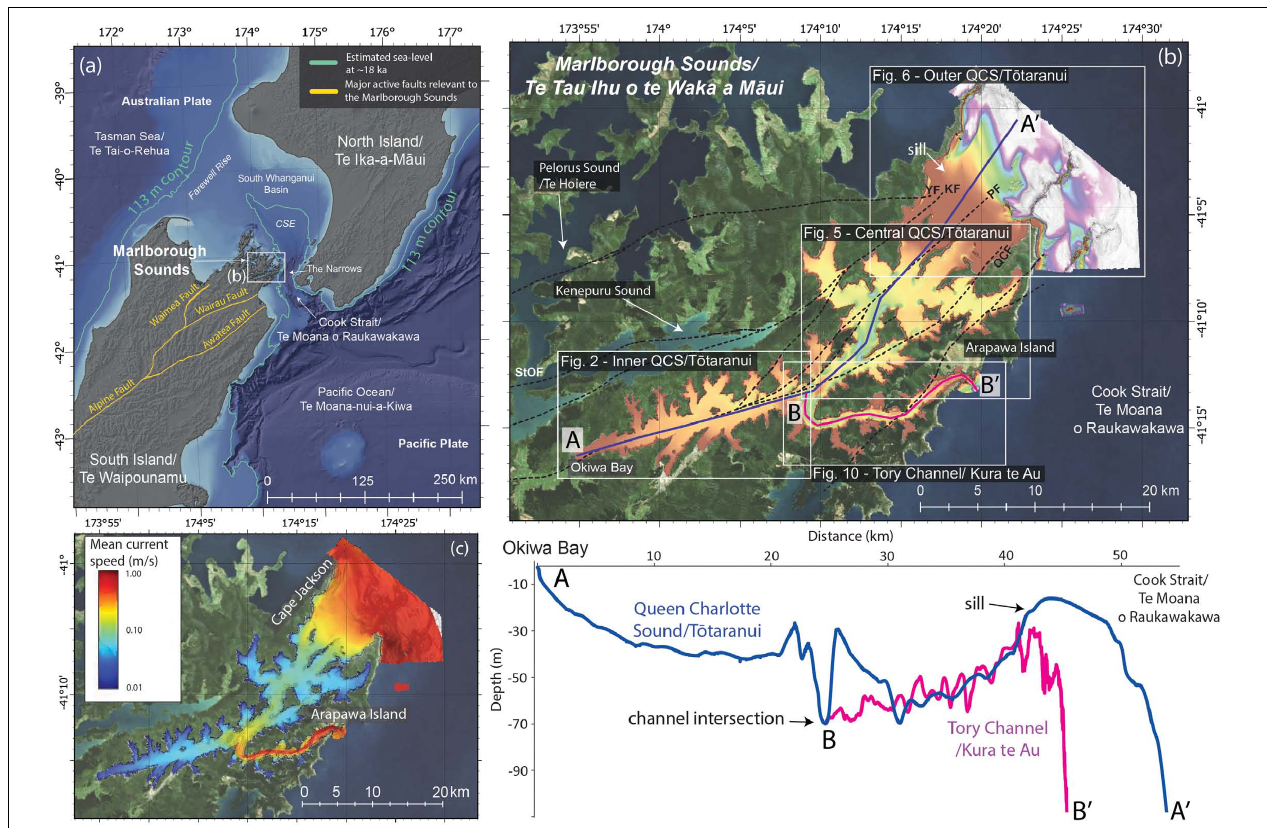
FIGURE 1 | (a) Location map of the Marlborough Sounds/Te Tau Ihu o te Waka a M ¯ aui region with labeled features described in the text. Green line represents the 113 m bathymetric contour which, depicts the estimated last glacial sea-level drop at ∼ 18 ka (Te Punga, 1953; Stevens, 1974; Proctor and Carter, 1989). CSE = Cook Strait Embayment. Yellow lines are the major active faults relevant to Marlborough Sounds (Langridge et al., 2016). White rectangle shows the location of the study area and inset (b). (b) Regional view of QCS and TC with satellite imagery overlain by the area mapped by multibeam echosounders (HS51 data). White rectangles show locations of Figures 2 , 5 , 6 , 10 and the division of the QCS and TC into 4 distinct geomorphological domains. Navy blue line represents the location of Profile A-A’ from Okiwa Bay in the inner QCS to the Cook Strait/Te Moana o Raukawakawa in the outer QCS. Pink line shows the location of Profile B-B’ from the channel intersection between QCS and TC and Cook Strait. Dashed black lines are inferred concealed faults from Begg and Johnston (2000), including Picton Fault (PF), Queen Charlotte Fault (QCF), Kenepuru Fault (KF), St Omer Fault (StOF), Yncyca Fault (YA) and several unnamed faults. Contextual information and features described in the main text are labeled. (c) Modeled mean current speeds (ms − 1 ) in the QCS and TC at 5 m water depth, based on one year’s hourly data from the 200 m resolution model of Hadfield et al. (2014). Note: color scale is